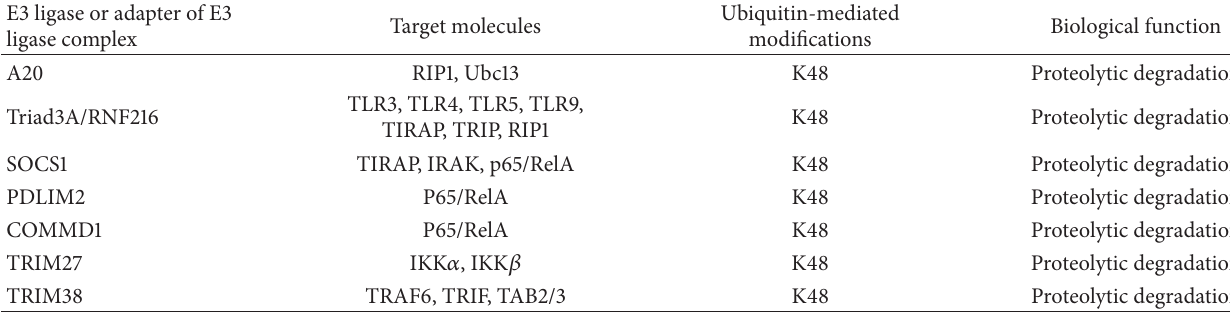
Table 2: Negative regulators of TLR signaling involved in ubiquitination.